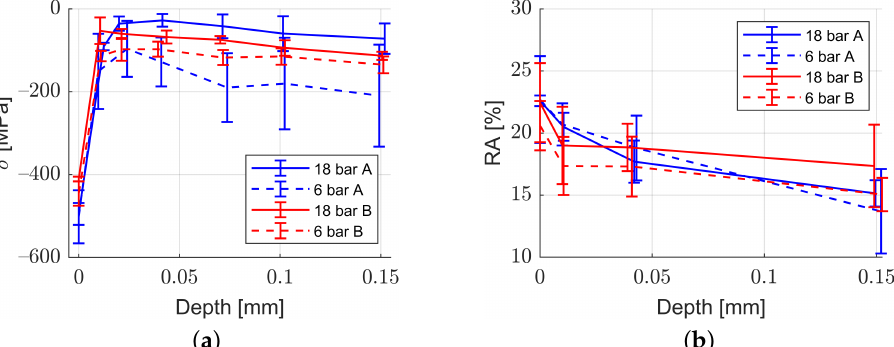
Figure 4. ( a ) Residual stresses in the direction from the gear tooth tip to root and ( b ) retained austenite content at different depth for both steel grades and cooling treatments with 20MnCr5 (A) and 17NiCrMo6-4 (B).